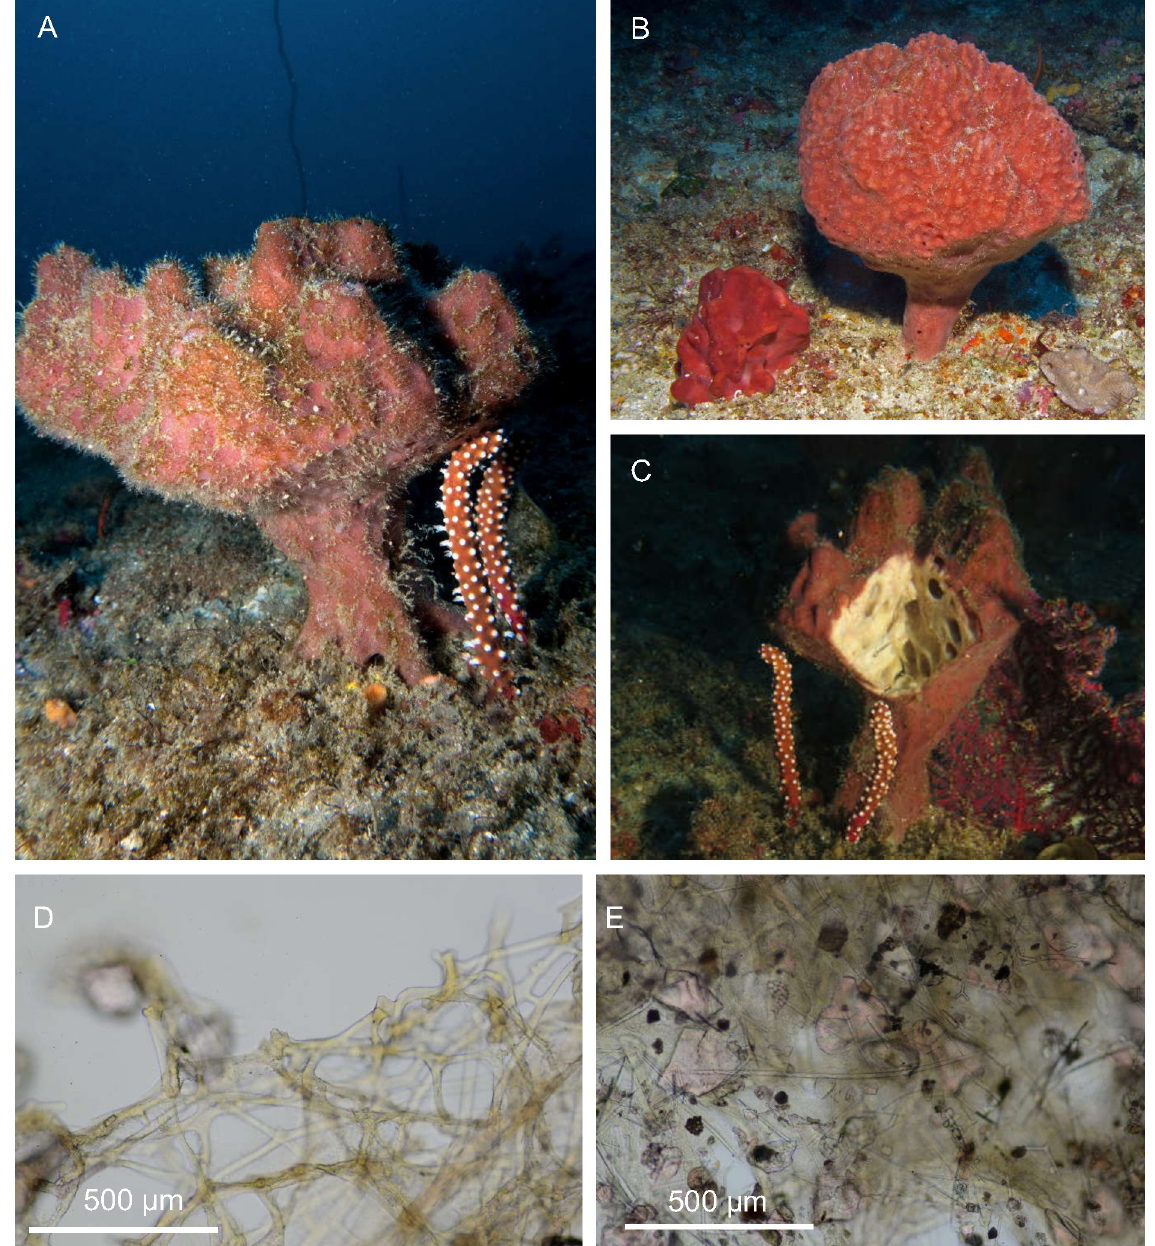
Fig. 5. Hyattella pedunculata Calcinai & Belfiore sp. nov. A, C . Specimen in situ , paratype MSNG 61419; C shows the internal, lacunose body. B . Holotype MSNG 61418. D . Network of fibers. E . Superficial cuticle with foreign